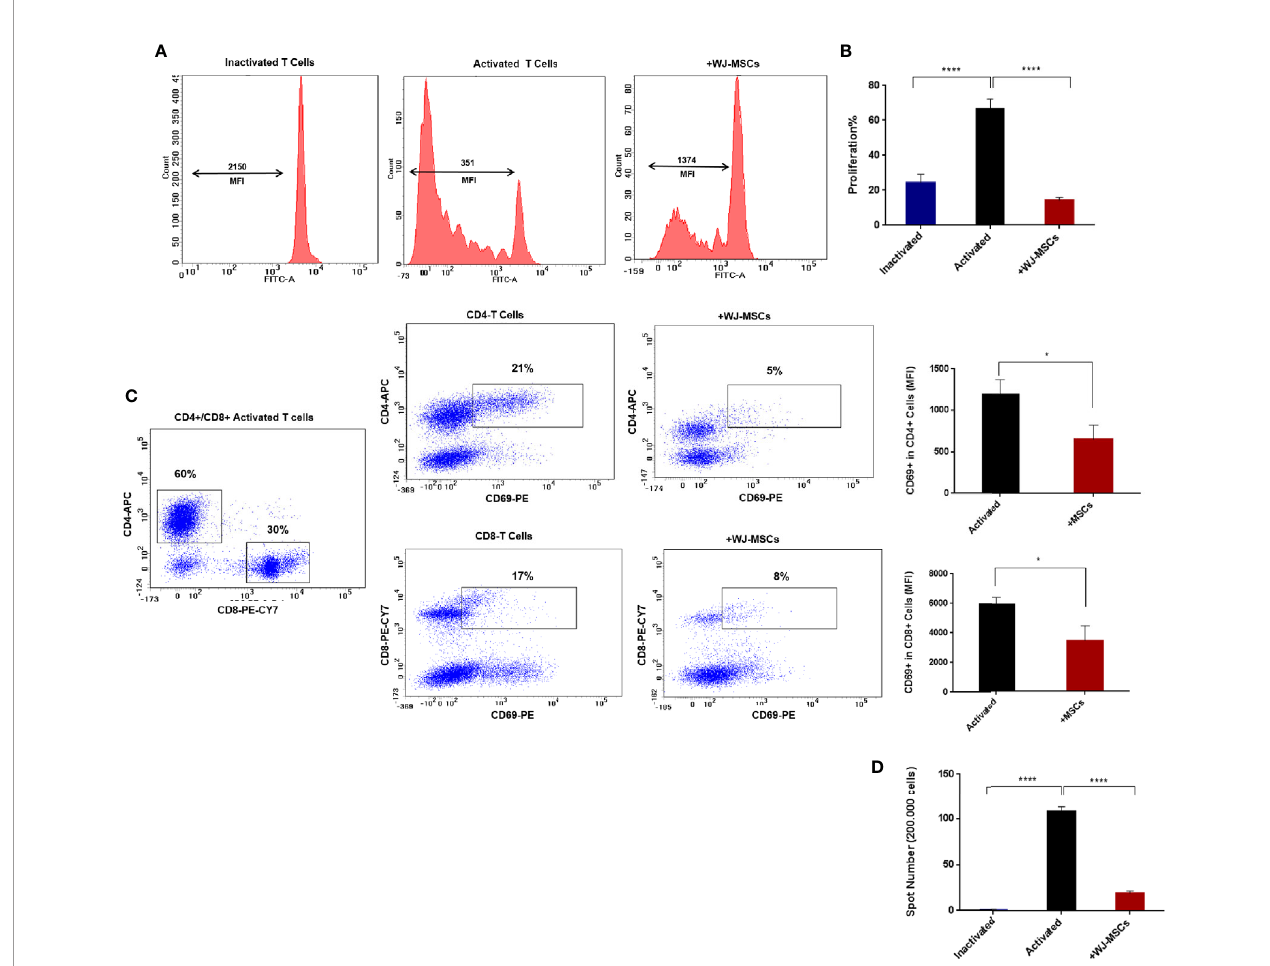
FIGURE 3 | T cells proliferation and activation and IFN- g ELISPOT analysis (A) Representative fl ow cytometry analysis and mean fl uorescent intensity (MFI) the dilution of CFSE fl uorescent dye (B) Percentage of T cell proliferation under the following conditions: inactivated T cells (blue), activated T cells cultured without (black) and with primed WJ-MSCs (red). Statistical signi fi cance was tested using a one-way ANOVA with Tukey ’ s post hoc for multiple comparisons (C) Representative fl ow cytometry analysis of CD4+/ CD8+ activated T cells and activated CD69+ T cells cultured with and without primed WJ-MSCs and MFI ± SD of CD69+ T cell in